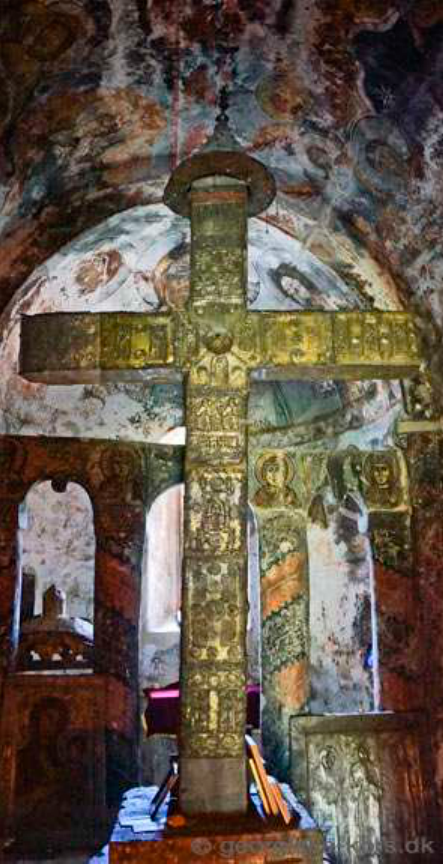
Figure 1. Pre-altar Cross; photograph taken by Norma Mikeladze-Andersen; http://www.georgiske- kors.dk.